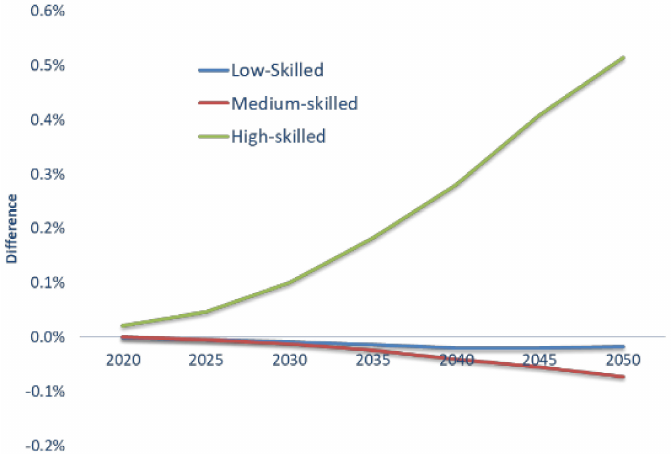
Figure 10. EU employment impacts by skill of 2DEG_SK scenario (% changes from